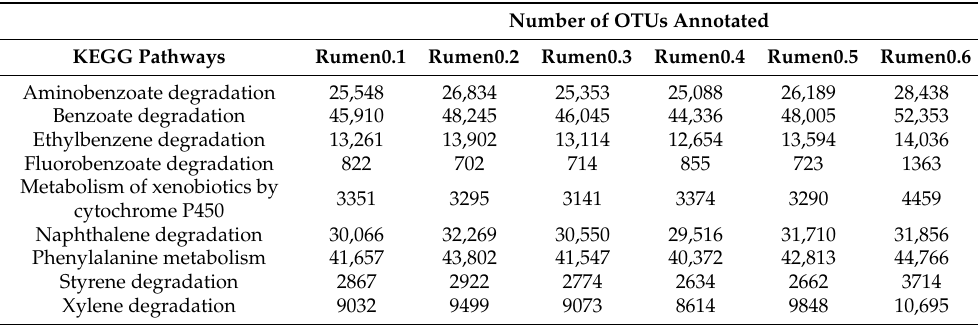
Table 8. Number of operational taxonomic units (OTUs) relate to aromatic compounds in Kyoto Encyclopedia of Genes and Genomes (KEGG) function